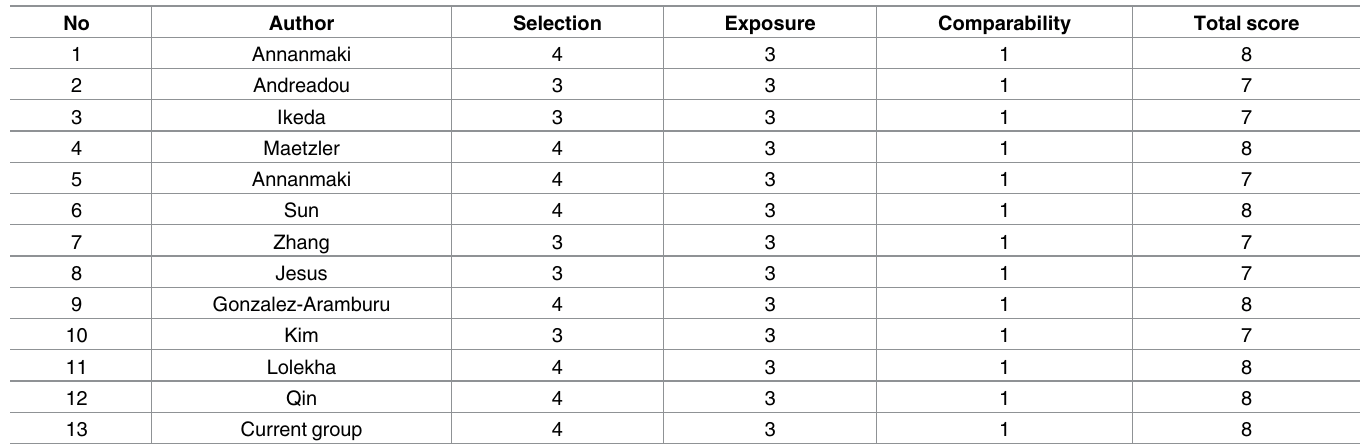
Table 2. Results of quality assessment.